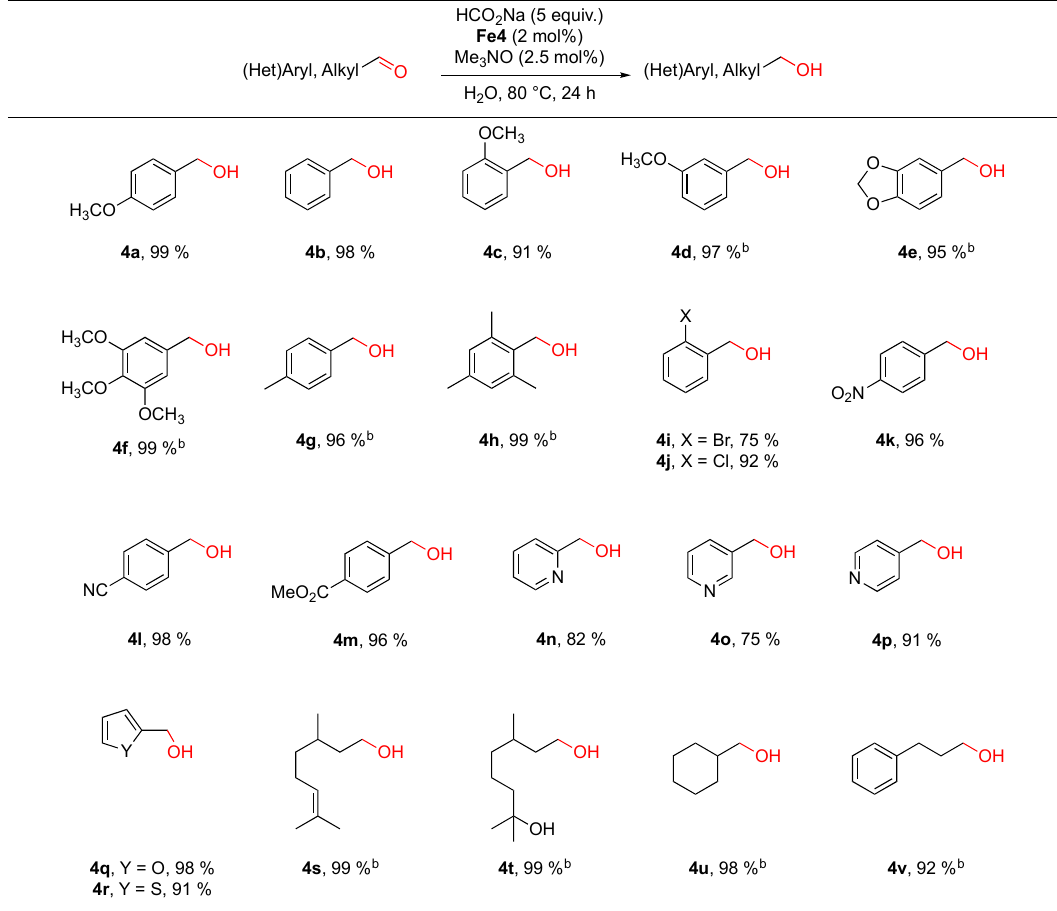
Table 2. Iron-catalyzed reduction of aldehydes with sodium formate a .